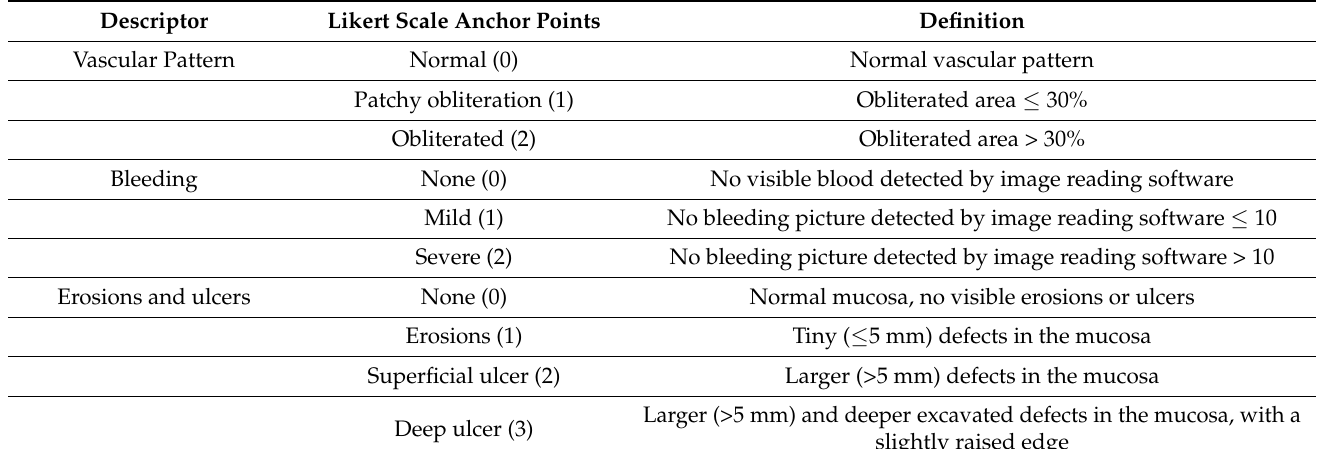
Table 3. CSUS descriptors and